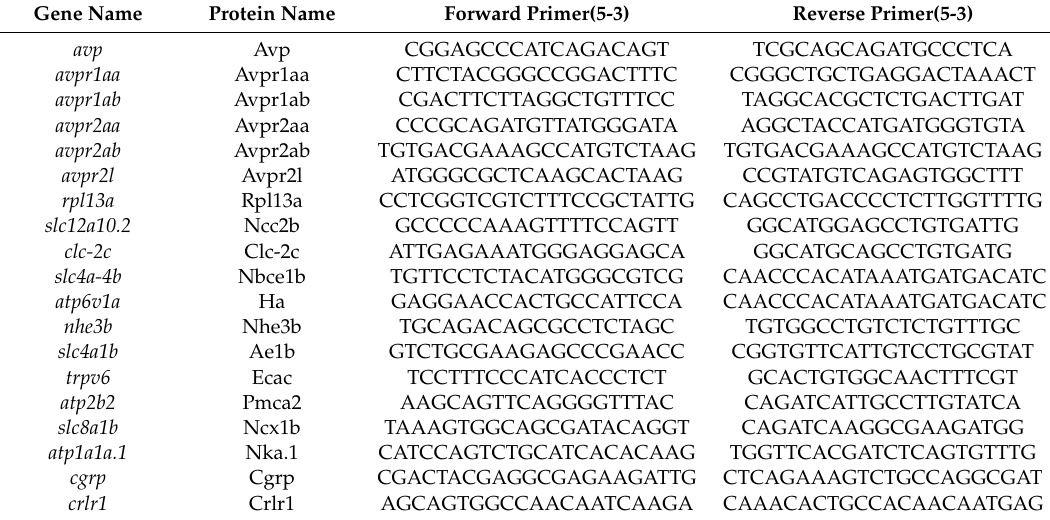
Table 1. Specific primer sequences of quantitative real-time polymerase chain reaction